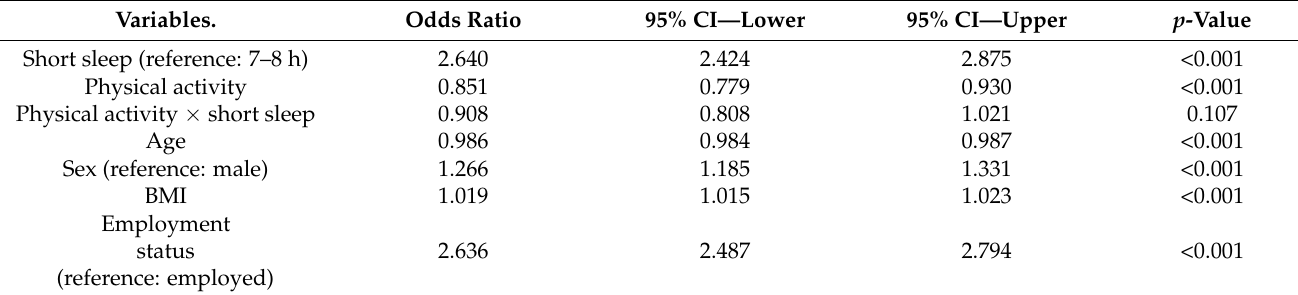
Table 12. The moderating effect of physical activity on the relationship between short sleep and emotional distress predictions among Blacks ( n =